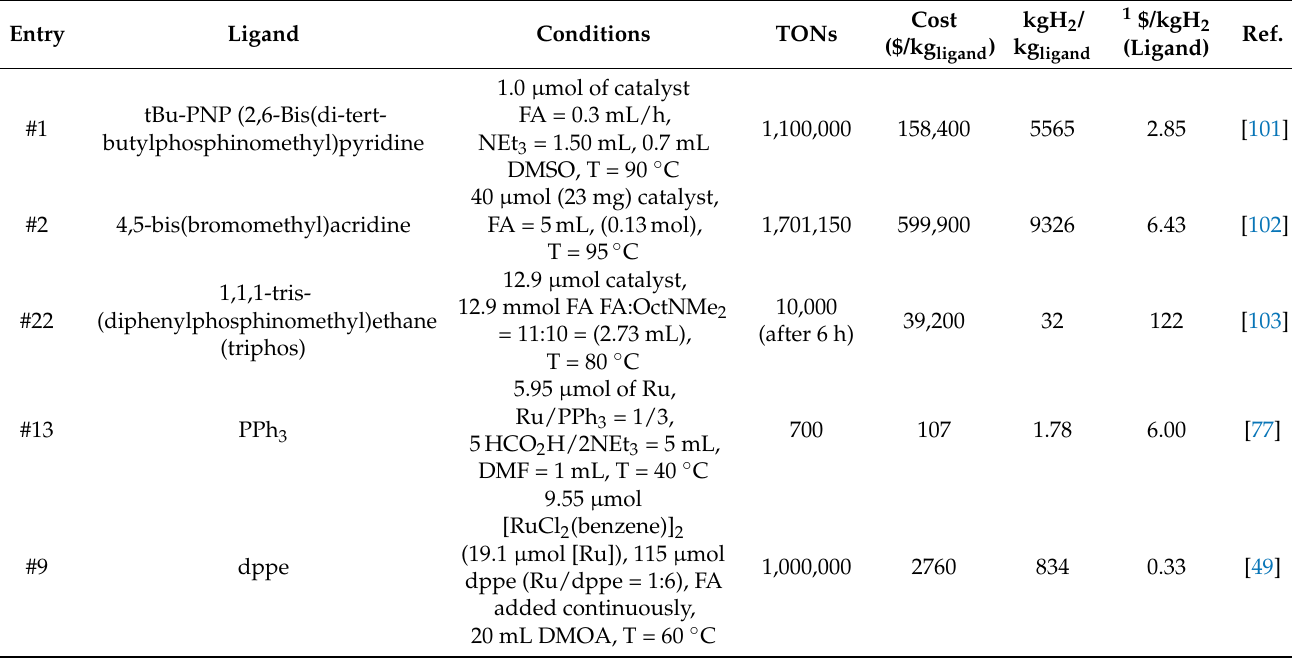
Table 2. Cost analysis based on the